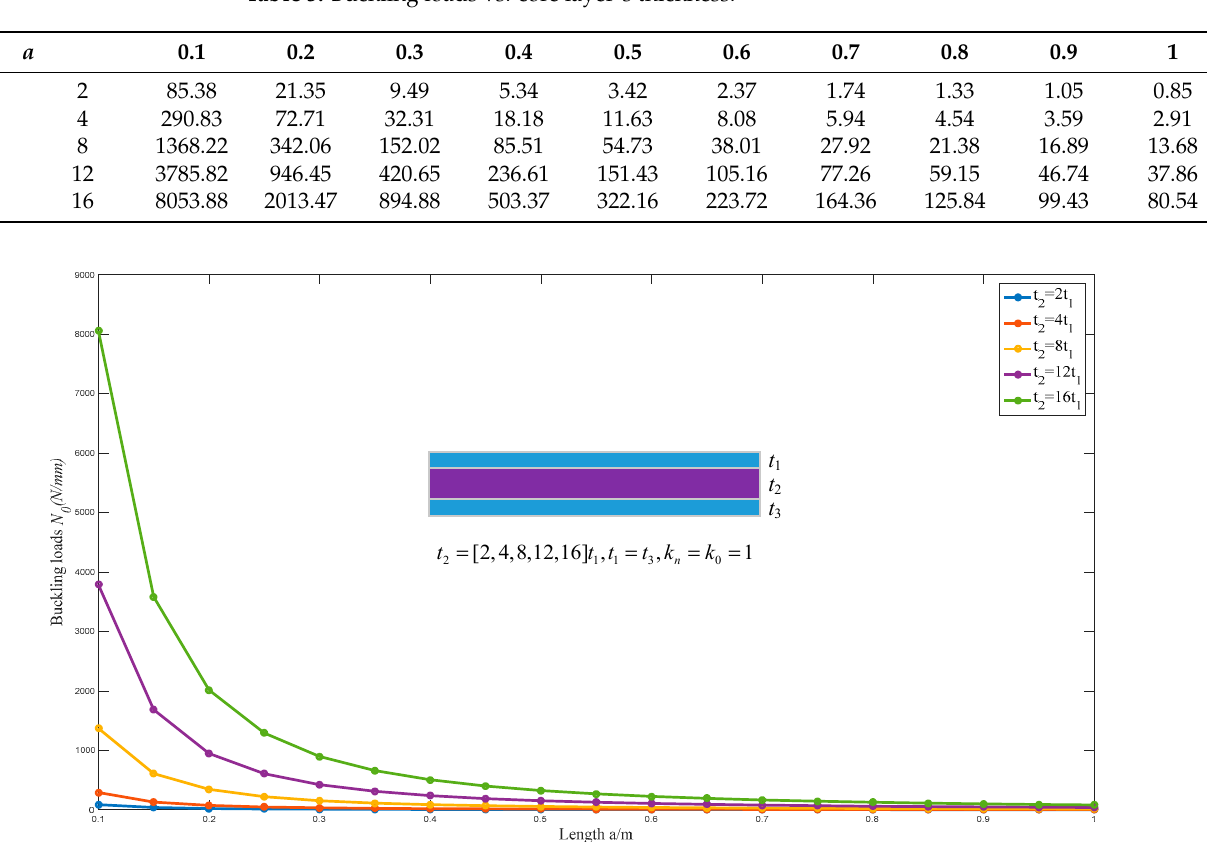
Figure 8. Buckling loads affected by the thickness of the core layer.